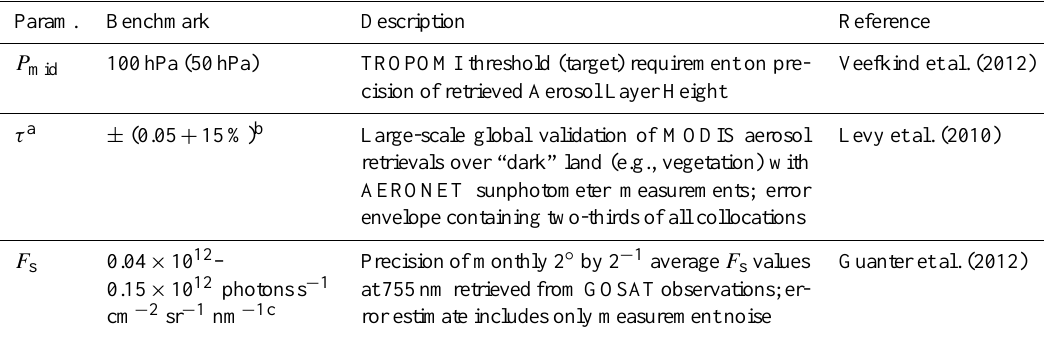
Table 2. Benchmark numbers for comparing the precision of retrieved mid pressure, aerosol optical thickness and fluorescence emission as found in this study. Param.